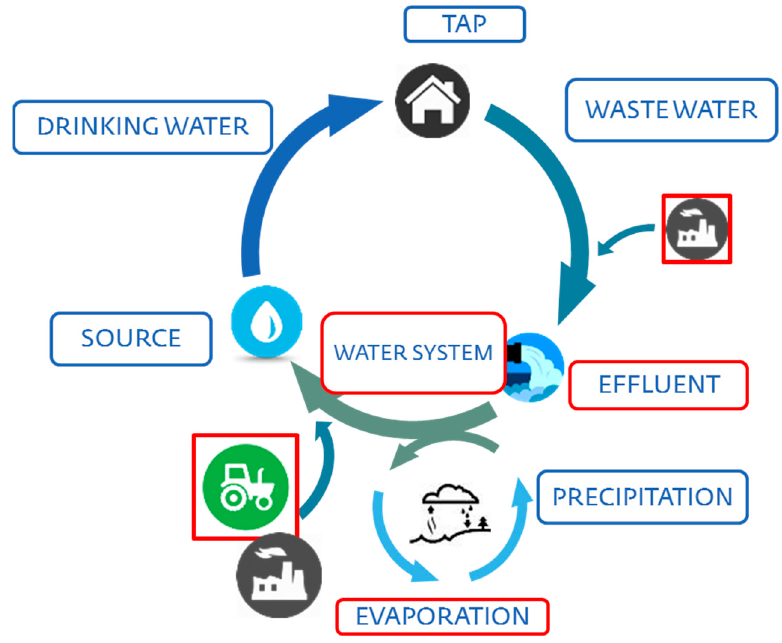
Figure 1. Water management cycle